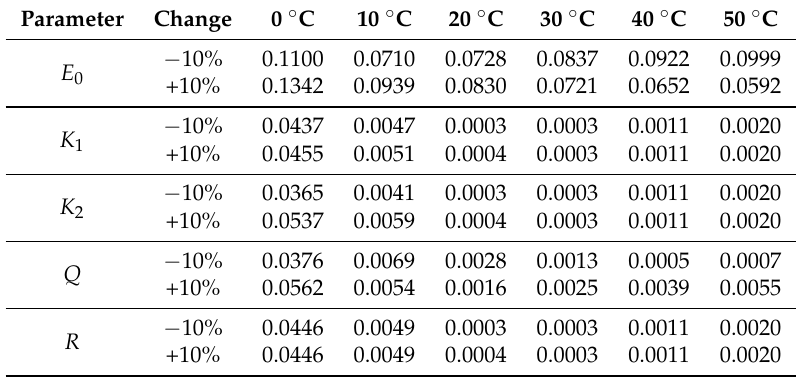
Table 2. Values of the loss function in case of the parameter sensitivity analysis of the charge